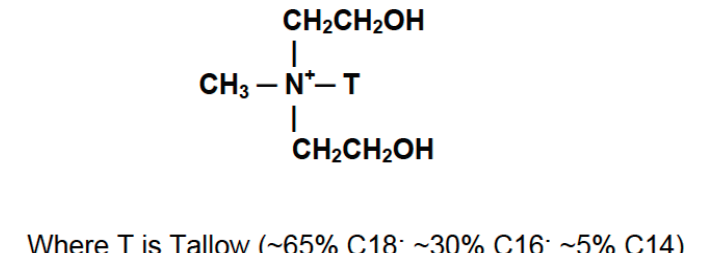
Figure 1. Quaternary ammonium salt used as modification of natural